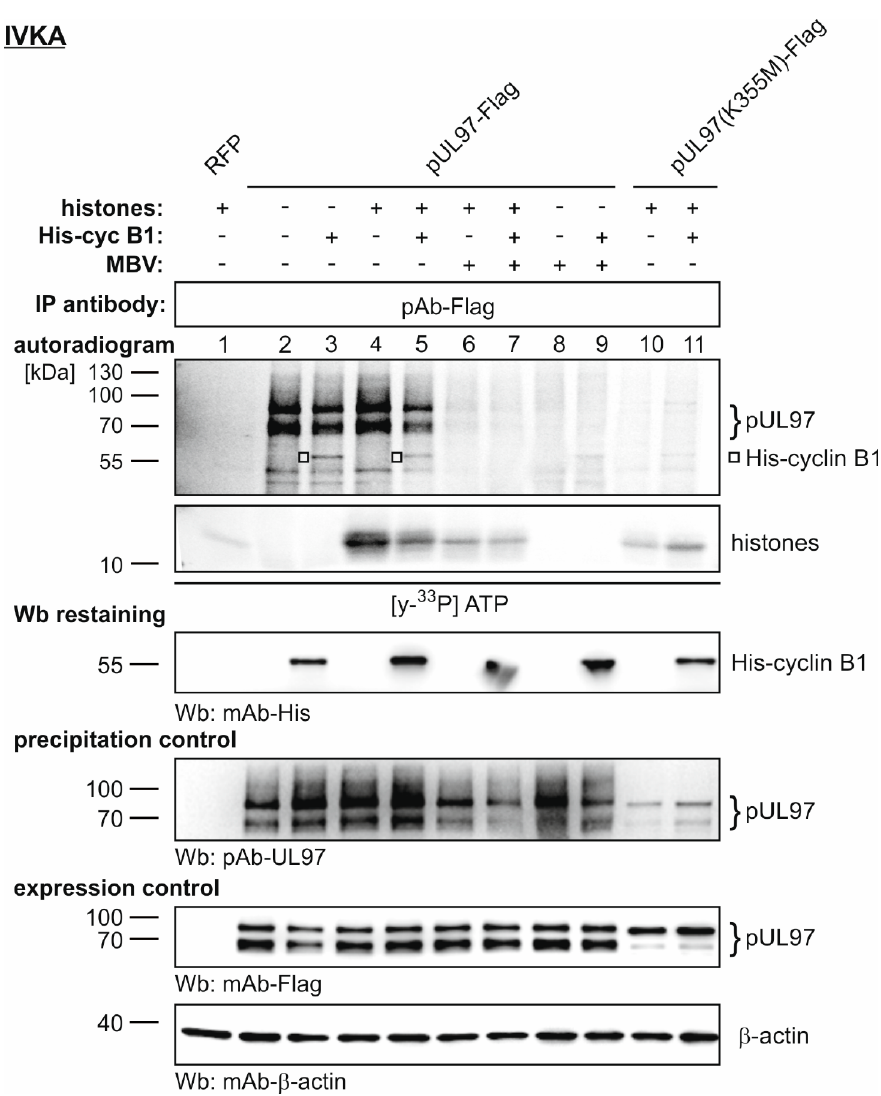
Figure 4. A pUL97 ‐ specific in vitro kinase assay (IVKA), determining the putative modulatory effect of cyclin B1 association with pUL97. Transiently expressed pUL97 ‐ Flag or pUL97(K355M) ‐ Flag were harvested in a cyclin ‐ depleted fashion by applying high ‐ stringency IP. The two versions of pUL97 were subjected to IVKA reactions under standard conditions. Each reaction was supplemented by the addition of either human cyclin B1 (2 μ g), human histones (20 μ g) or pUL97 inhibitor MBV (3 μ M) as indicated. Upper panels, IVKA (autoradiogram) and detection of His ‐ cyclin B1 on the IVKA membrane (Wb restaining); middle panel, detection of comparable pUL97 levels (precipitation control); lower panels, total input levels contained in cell lysates (expression control); RFP, red fluorescence protein (used as a transfection control).